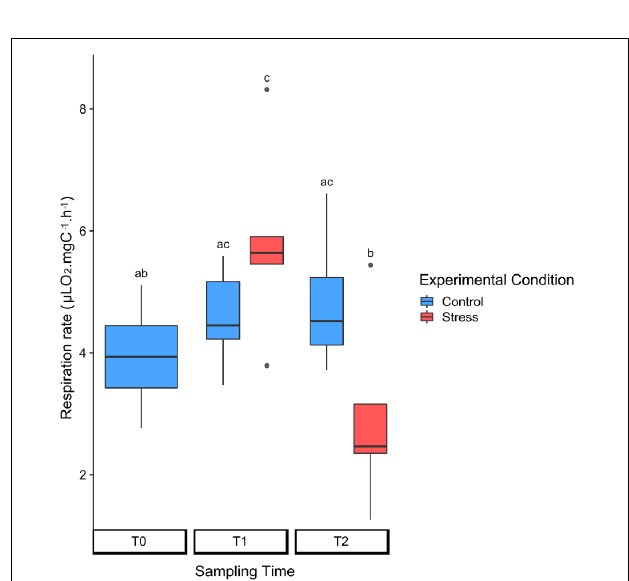
FIGURE 3 | Normalized respiration rates in control (blue) and heat-stressed (red) colonies of Collozoum pelagicum . The rates are normalized to the surface area of the colony. Control colonies were maintained at 21 ◦ C, while stressed colonies were sampled at 25 ◦ C (T1) and 28 ◦ C (T2). Pairwise comparison from permutation test between each condition was represented by letters. Statistical supports are described in Supplementary Tables 1, 4A .